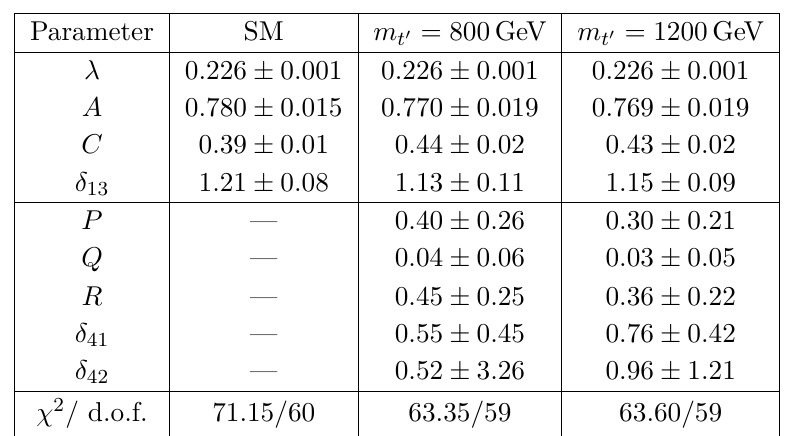
Table 1 . Best fit parameters for the quark mixing matrix with a vector-like quark isosinglet t 0 included. These are shown for two benchmark quark masses m t 0 = 800 GeV and m t 0 = 1200 GeV outlined in table 4 of ref.